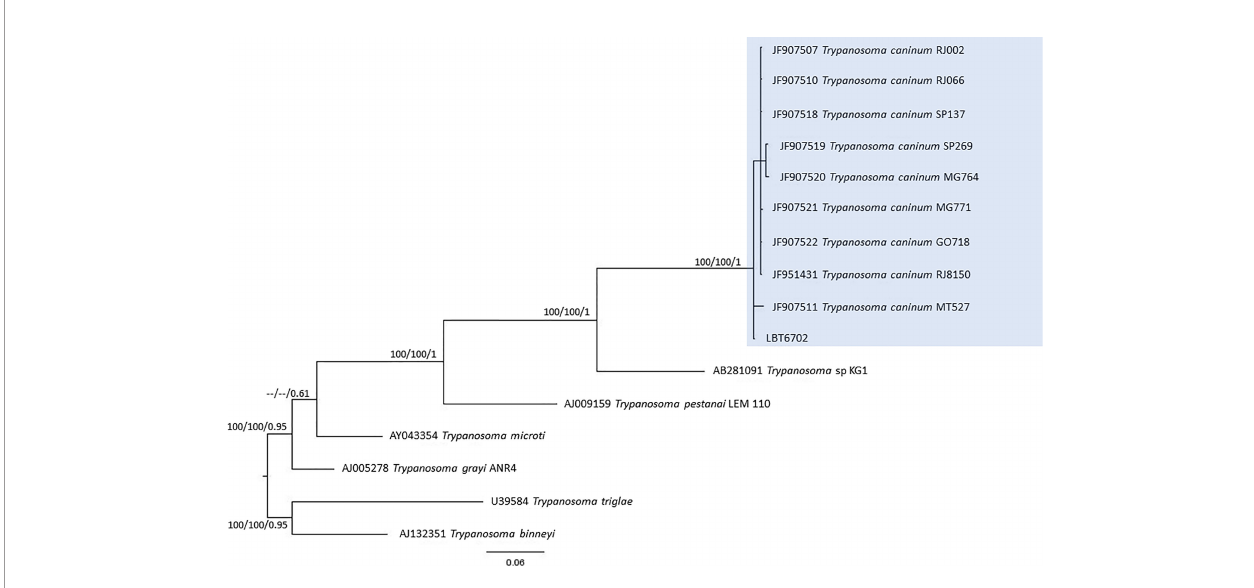
FIGURE 5 | Trypanosoma caninum phylogenetic tree based on 605 base pair SSU rDNA fragment lengths from dog blood clots. The tree was inferred using transitional with amino acid frequencies and freeRate heterogeneity (TIM+F+R2) and symmetrical plus gamma distribution (SYM+G) models for ML and BI, respectively. The numbers at nodes correspond to ML (ultrabootstrap, SH-aLRT) and BI (posterior probability). The scale bar shows the number of nucleotide substitutions per site. The blue square represents the clade formed by LBT6702 with other T. caninum sequences from different Brazilian